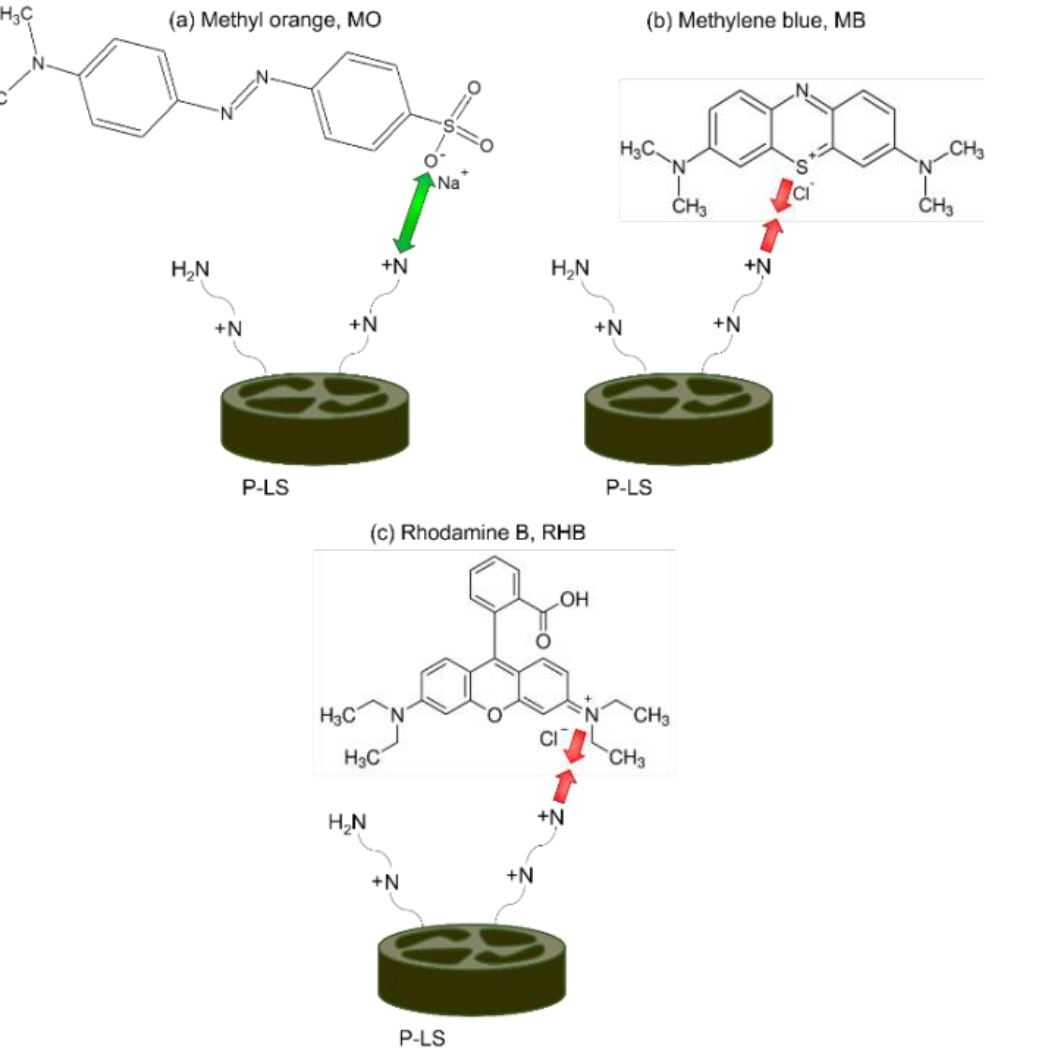
Figure 9. P − LS interaction with methyl orange ( a ), methylene blue ( b ), and rhodamine − B ( c ).